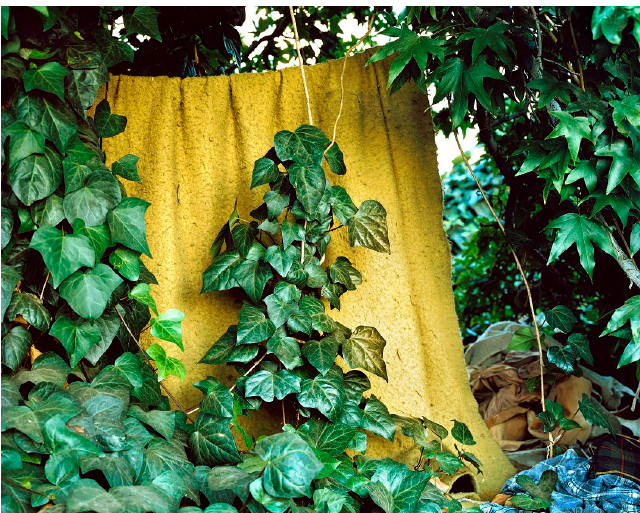
Figure 3. Anthony Hernandez, Landscapes for the Homeless #14 (1989), © Anthony Hernandez.